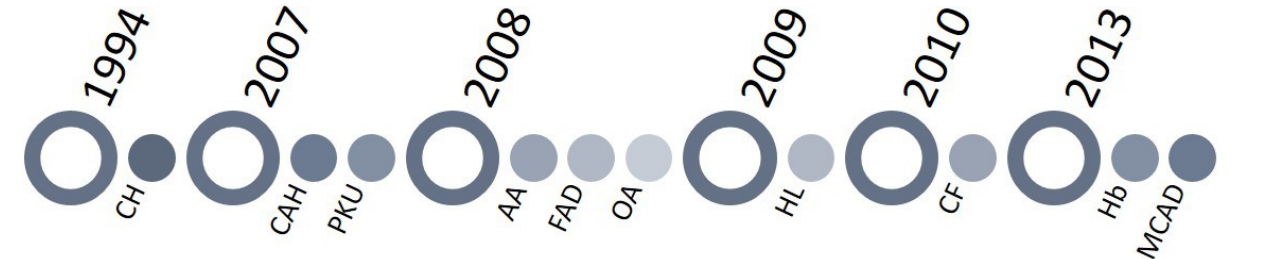
Figure 1. Evolution of the diseases incorporated to NNSS. CH: Congenital hypothyroidism; CAH: Congenital Adrenal Hyperplasia; PKU: Phenylketonuria; AA: amino acid defects; FAD: fatty acid defects; OA: organic acidemias; HL: Hearing loss; CF: Cystic fibrosis; Hb: hemobloginopathies; MCAD: medium chain Acil CoA dehydrogenase